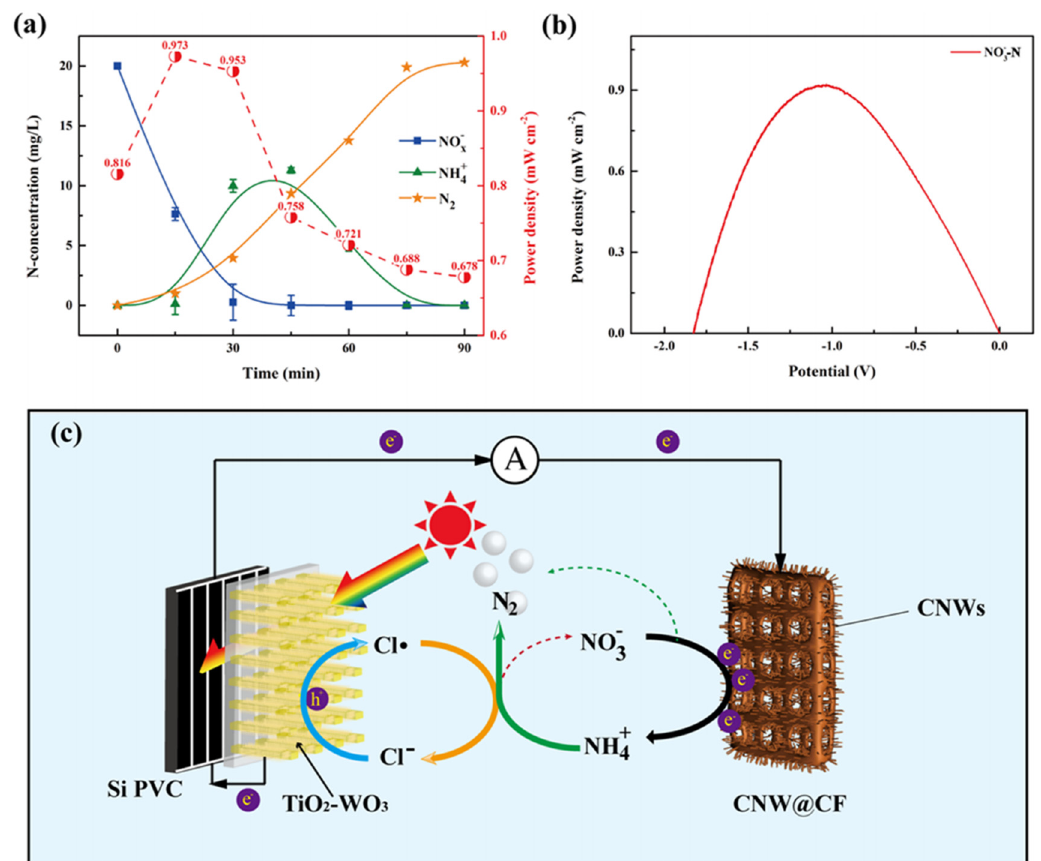
Figure 4. ( a ) N concentration of NH 4+ , NO x − , and N 2 (left panel, Y axis) and power density (right panel, Y axis) in the DFC system during the reaction. Under the conditions of 100 mW cm − 2 solar energy, pH = 5, 0.03 M concentration of Cl − . ( b ) Power density at different potentials with the highest power density conditions of NO 3 − − N. ( c ) Schematic diagram of the NO 3 − − to N 2 − transformation in the DFC system [53] .